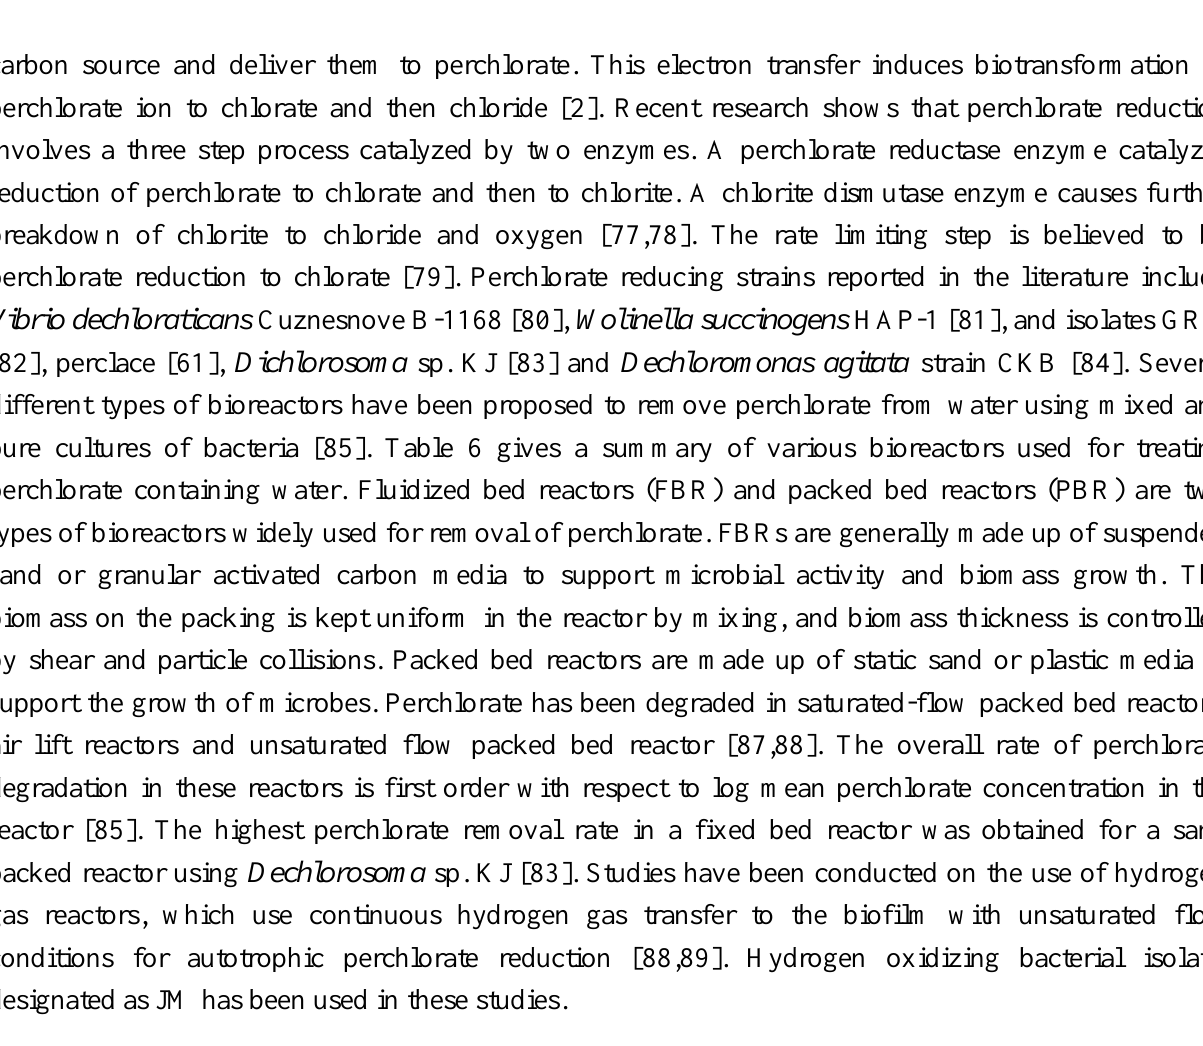
Table 6. Summary of Bioreactor studies for perchlorate